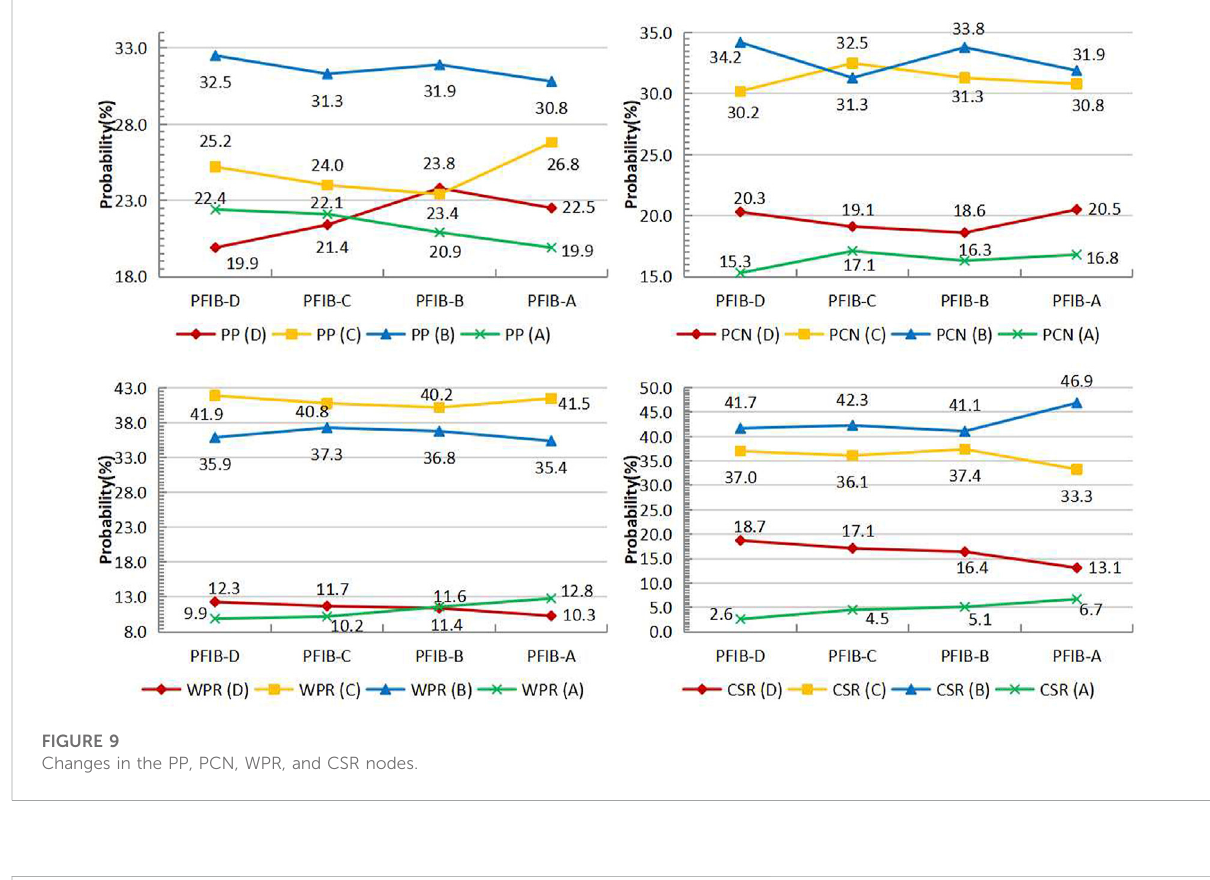
FIGURE 9 Changes in the PP, PCN, WPR, and CSR nodes.